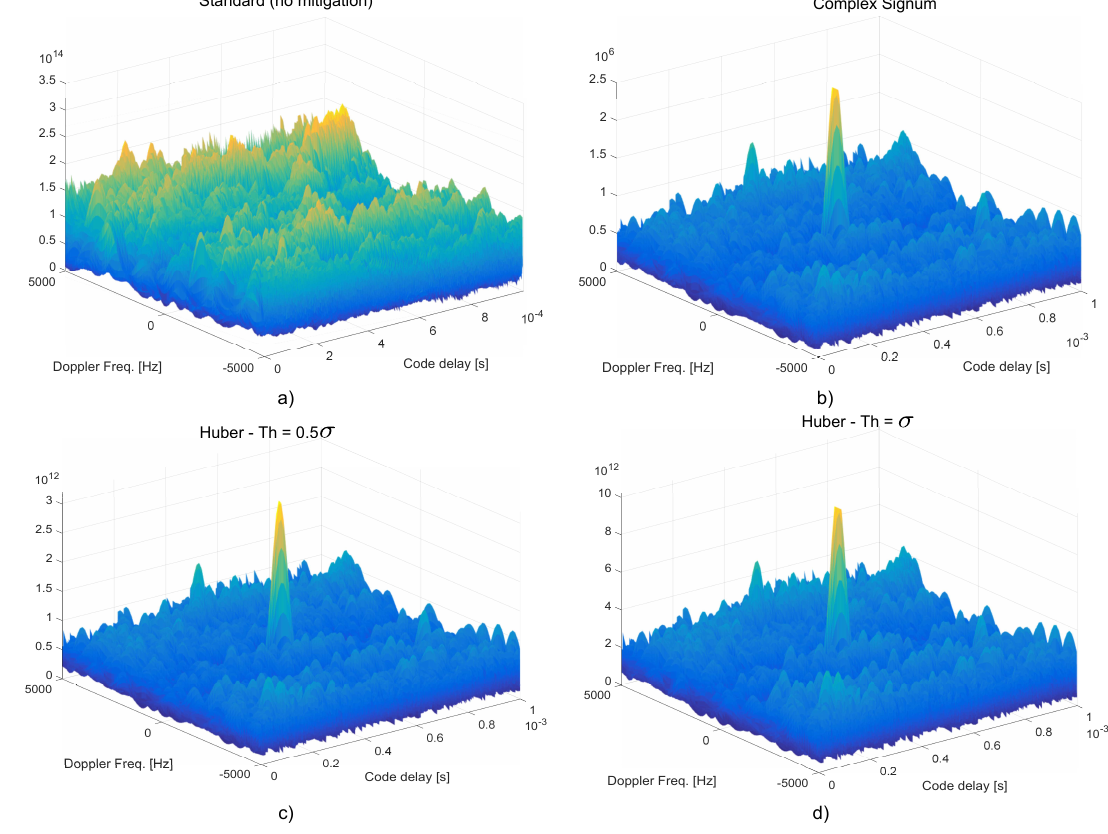
Figure 7. CAFs obtained using different time domain processing strategies and for high jamming levels. The data used for the CAF computation are from the anechoic chamber experiment and were collected after 1000 s from the start of the test. ( a ) Standard processing without mitigation. ( b ) Complex signum non-linearity. ( c ) Huber’s non-linearity with T h = 0.5 σ . ( d ) Huber’s non-linearity with T h = σ